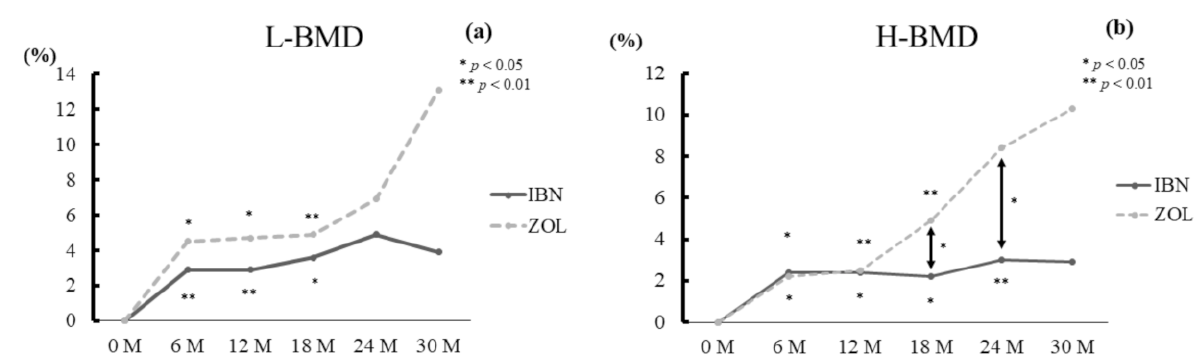
Figure 4. Percentage changes of L-BMD ( a ) and H-BMD ( b ). The ZOL group tended to exhibit enhanced gains in L-BMD and H-BMD compared with the IBN group. However, these differences were not significant except for the percentage changes of H-BMD at 18 and 24 months. * p < 0.05, ** p <